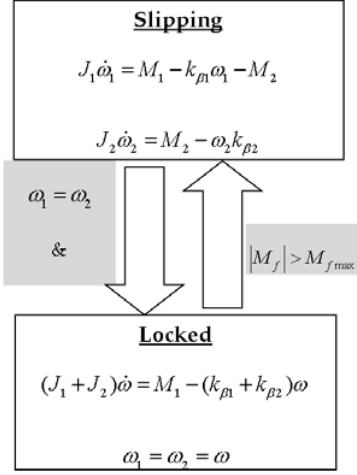
Figure 4. Shifting diagram modes.